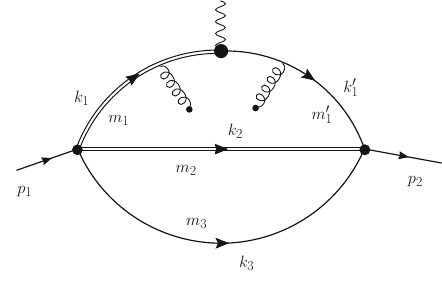
Fig. 7 One of the gluon–gluon condensate